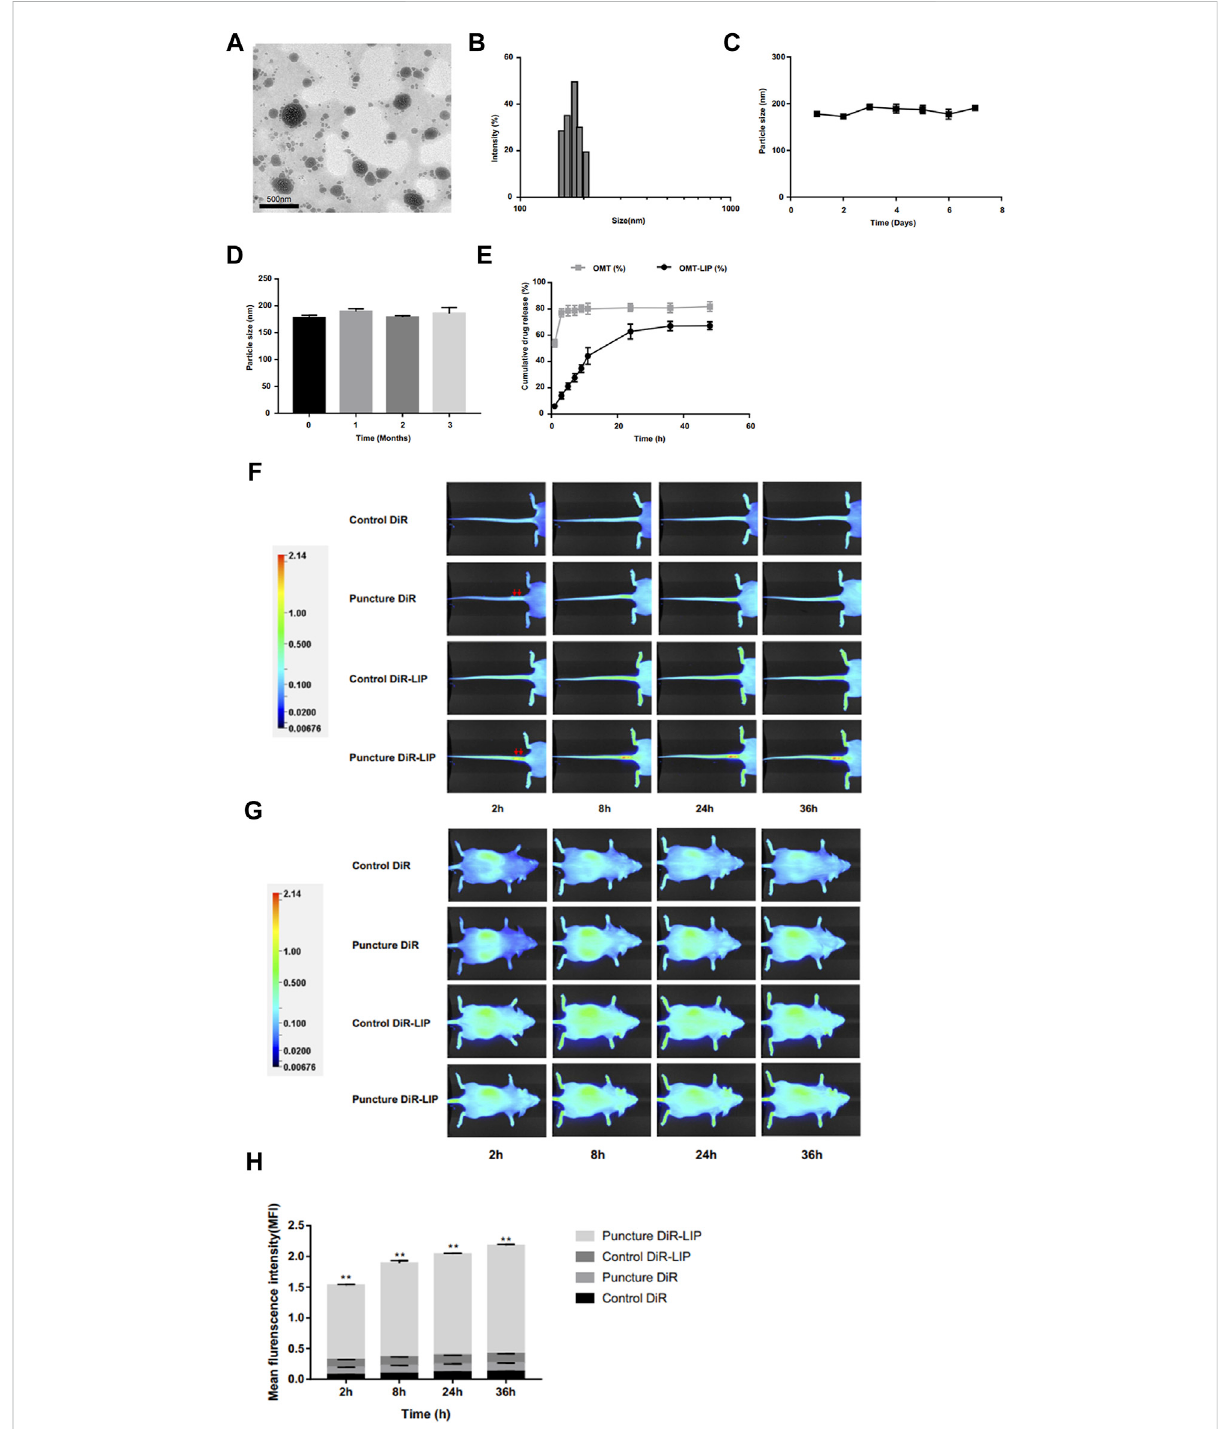
FIGURE 6 Image of oxymatrine liposome staining under the transmission electron microscope (A) . The particle size distribution of oxymatrine liposome (B) . The particle size changes of oxymatrine liposome during storage for 7 ° days (C) and 3 ° months (D) at 4 ° C. The curve of oxymatrine liposome releasing oxymatrine in vitro (E) . The NIFR images of the liposome delivery system biodistribution in tails (F) and whole bodies (G) at different timepoints (2, 8, 24, and 36 h). Red arrows indicate puncture sites. Statistical analysis of fl uorescence intensity at the degenerative discs (H) . (** p < 0.01). Reproduced with permission from (207).